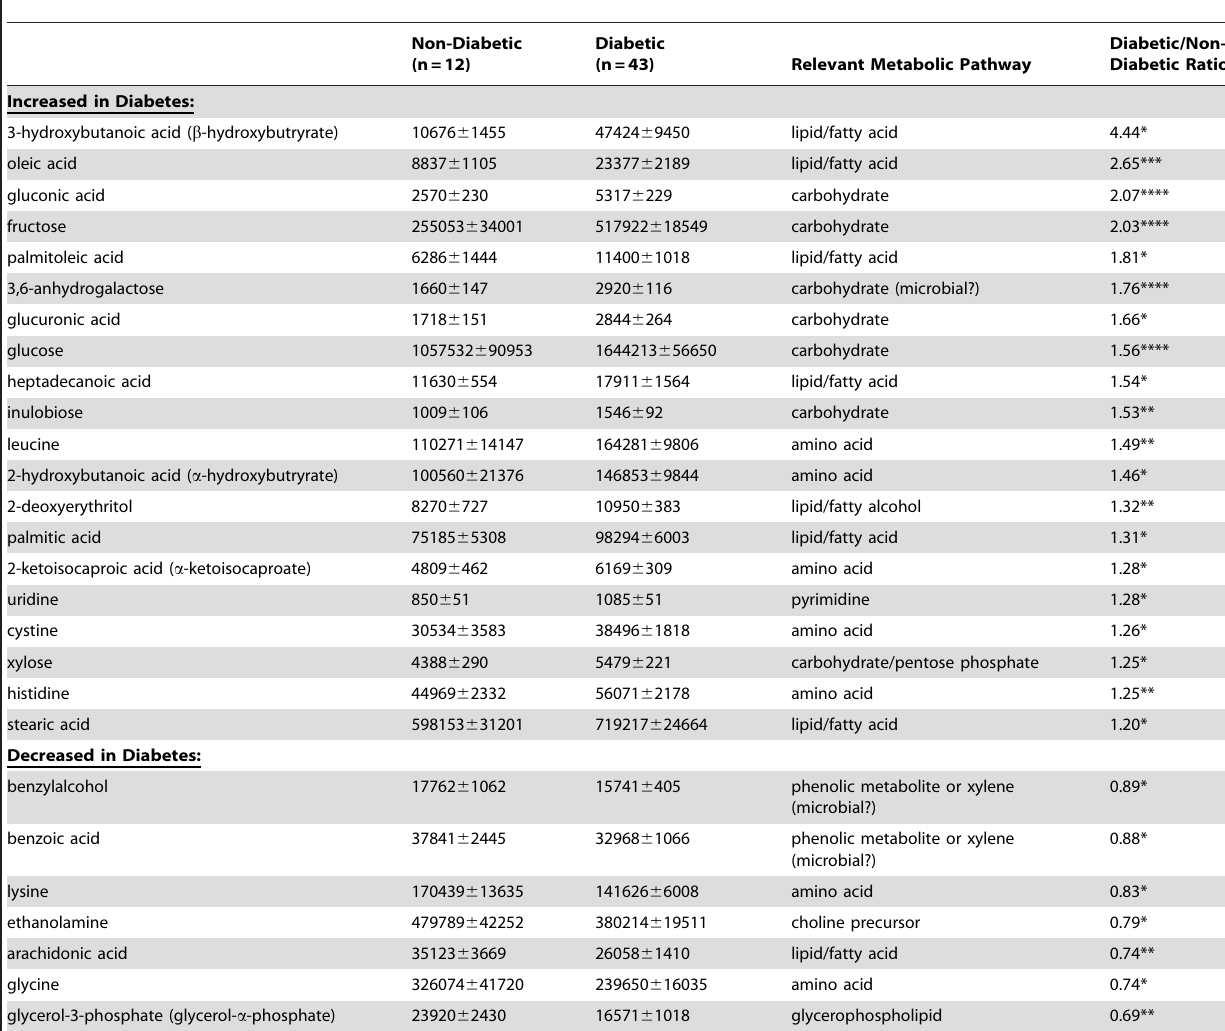
Table 2. Identifiable plasma metabolites with significantly-altered concentrations in obese non-diabetic vs. type 2 diabetic African-American women.